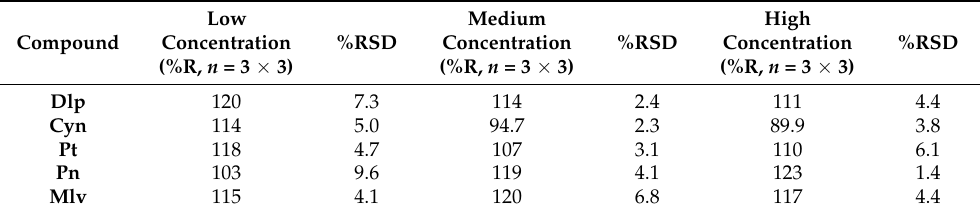
Table 5. Intermediate precision results of the method estimated as recoveries (%R, n = 3 × 3) for the studied anthocyanins at three fortification levels.